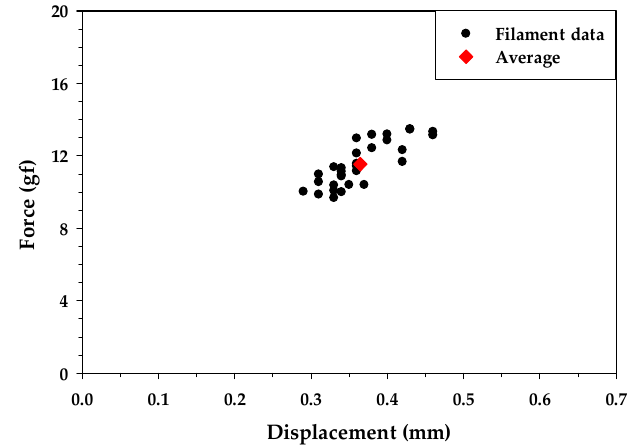
Figure 5. Filament tensile test results of OCF.